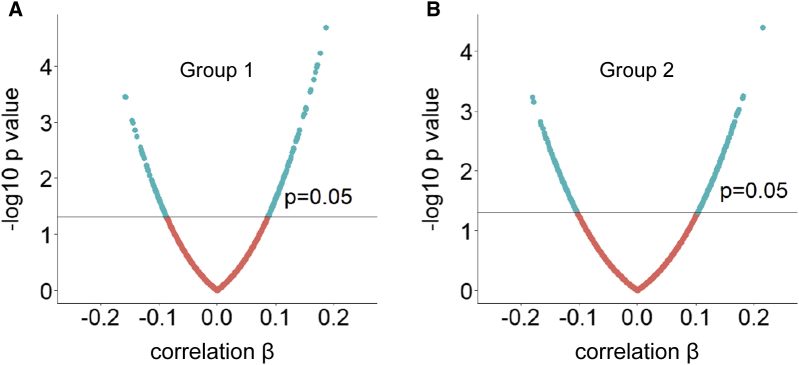
Correlation of plasma proteins with amyloid Z-score by partial Spearman correlation. (A and B) Volcano plot of proteins obtained from group 1 and group 2, respectively.